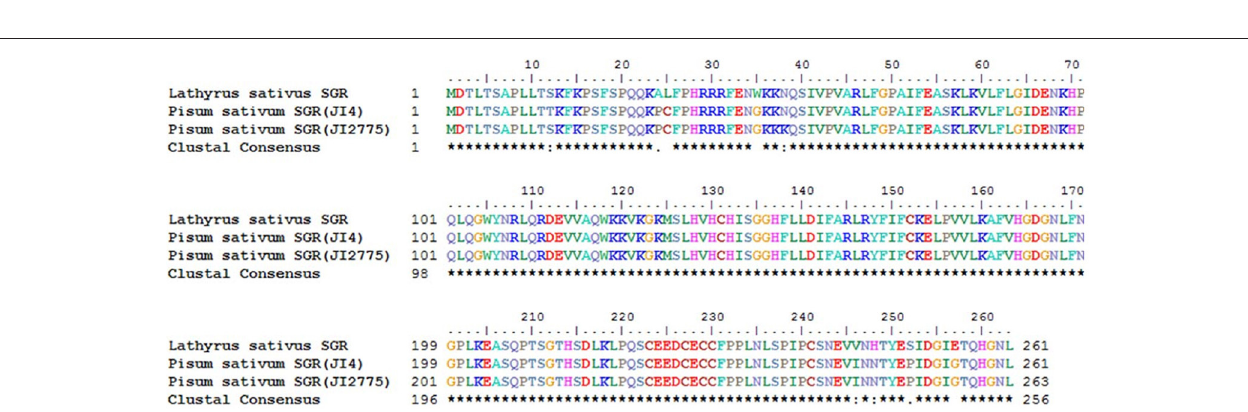
FIGURE 5 | Alignment between unigene c39901_g1_i1 annotated for senescence-inducible chloroplast stay-green protein of grasspea and SGR gene of pea.